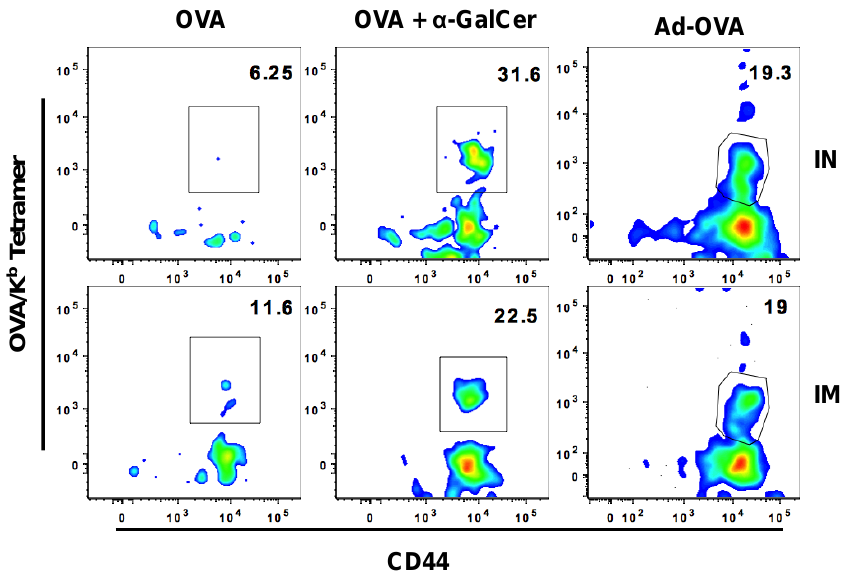
Figure 4. IN and IM immunization are equally effective at inducing OVA-specific CD8 + T cells in FRT. Plots show frequency of Ova-tetramer specific CD8 + T cells among CD8 + T cells present in FRT of mice immunized with either OVA, OVA + α GalCer, or Ad-OVA seven days after IN vaccination. Table4. Average frequency (± std. dev) of antigen specific CD8 + T cells isolated from the FRT of immunized mice.